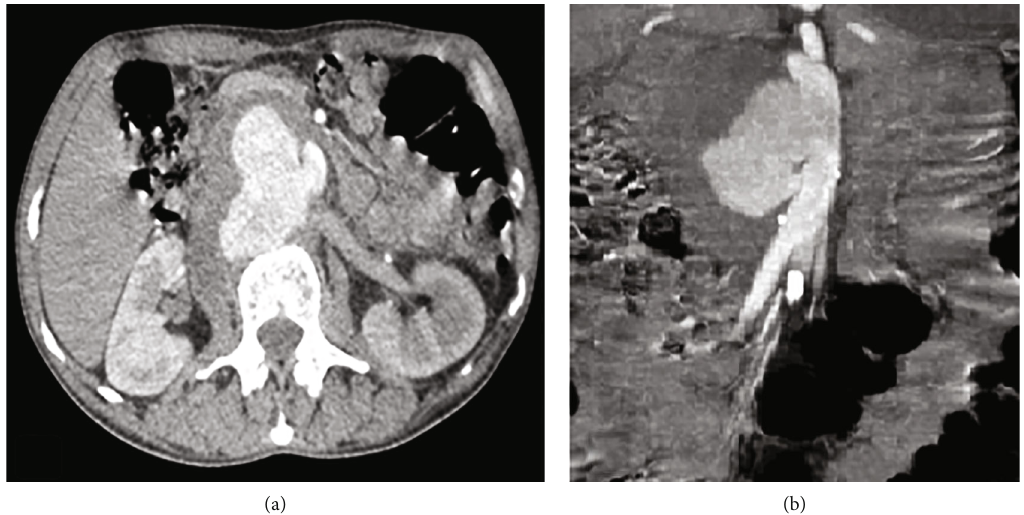
Figure 2: CT scan images showing the aortic pseudoaneurysm in an axial (a) and sagittal (b)